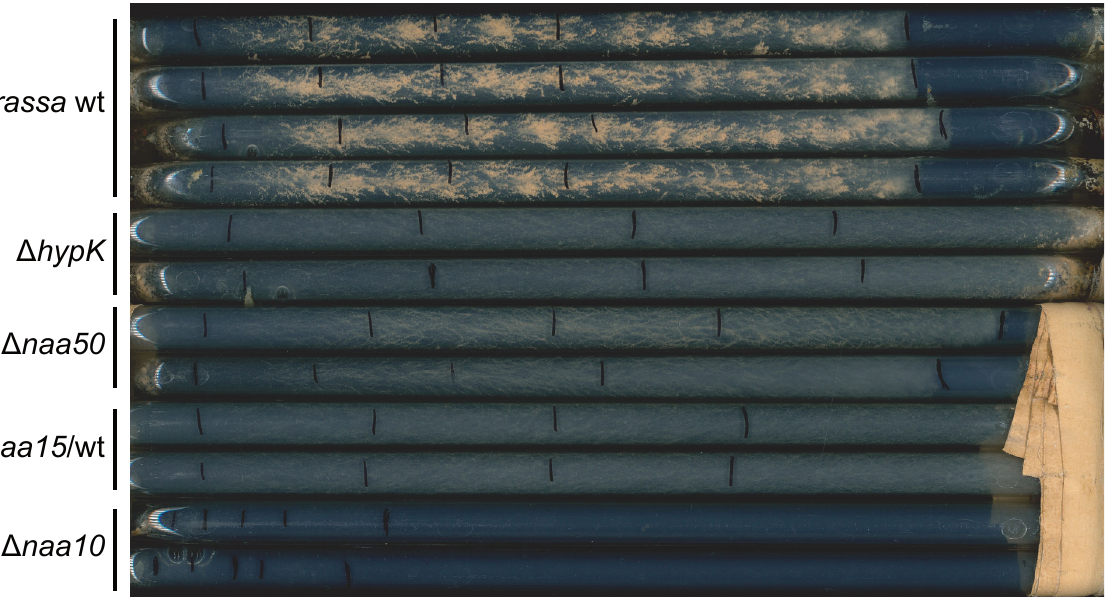
Figure 2. Knockout of naa50 and NatA subunits resulted in a Neurospora crassa growth phenotype. The wild-type (wt) strain formed typical conidia under light conditions at room temperature. Knocking out hypK , naa50 , naa15 (heterokaryon), and naa10 led to improper conidia formation and different growth patterns. Front growth was marked after every 24 h for 5